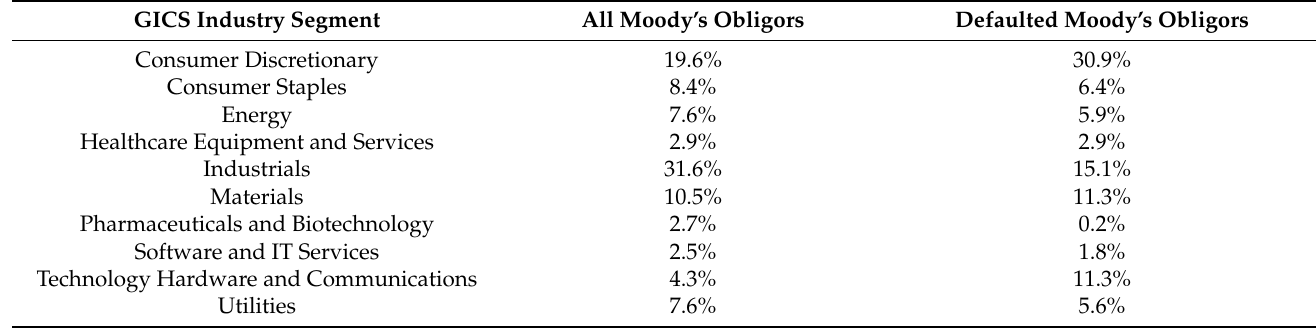
Table 1. Large Corporate Modeling Data—GICS Industry Segment Composition for All Moody’s Obligors vs. Defaulted Moody’s Obligors (1991–2015).